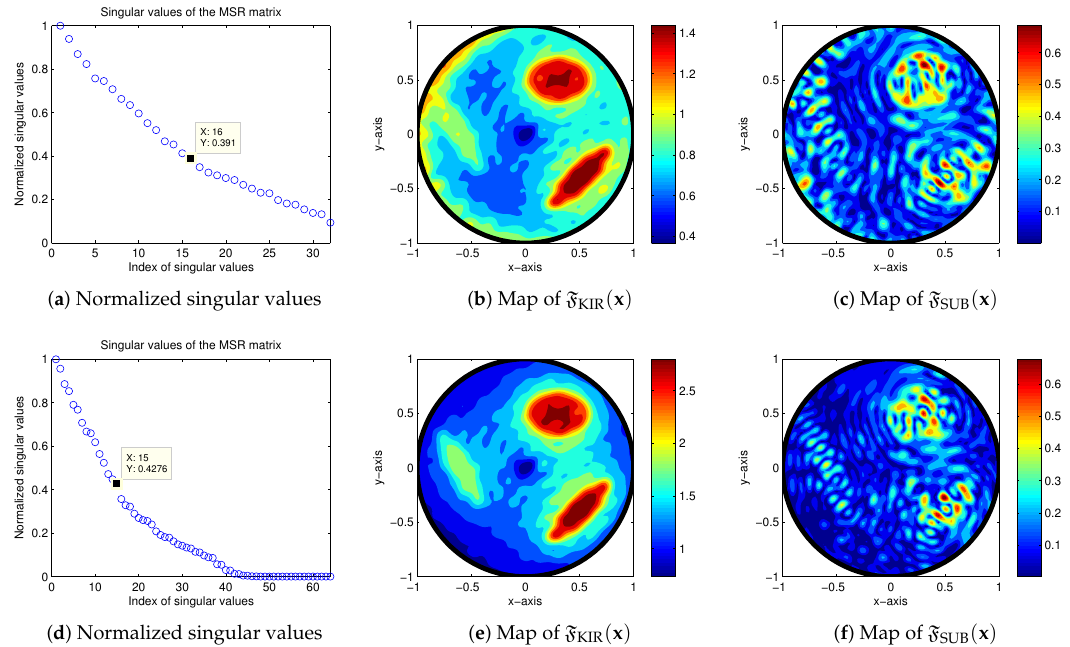
Figure 7. (Example 6) Distribution of normalized singular values, maps of F KIR ( x ) and F SUB ( x ) for λ = 0.3 with N = 32 directions ( top line ) and N = 64 directions ( bottom line ).